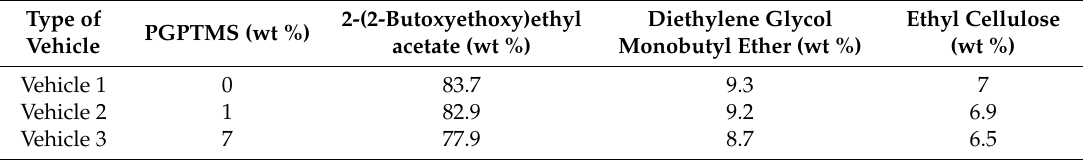
Table 3. Vehicle